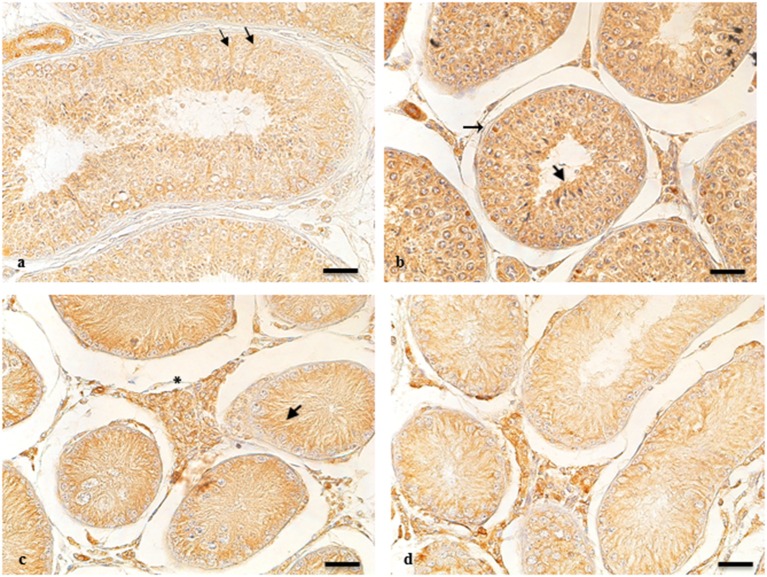
ARO-IR in cytotypes of normal and cryptic gonad of dogs. (a,d) Sertoli cells containing positive granules describing entire cellular profiles in normal and cryptic canine testis (arrow and arrowhead, respectively). (b) ARO-IR occurs as a single, intensely stained, granular structure, and is contained in the perinuclear cytoplasm of some spermatogonia (arrow). (c) a cluster of Leydig cells containing different quantities of reactive material in their cytoplasm in the retained male gonad (asterisk). Bar: 25 μm.